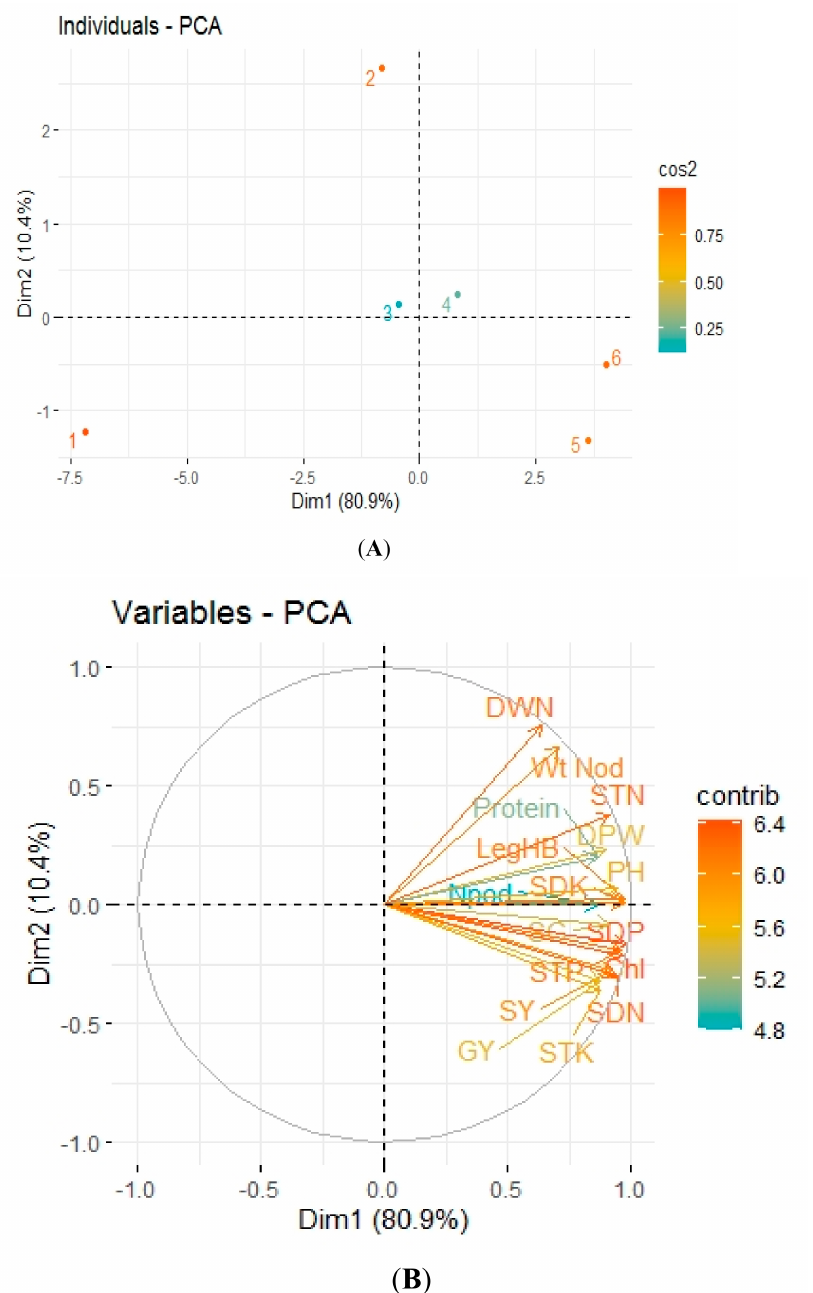
Figure 5. Score plots ( A ) and loading plots ( B ) of PCA on different attributes of chickpea by applica- tion of plant growth hormone alone and in combination with Rhizobium sp . Score plots ( A ) represents separation of treatments as (1) Control, (2) Rhizobium inoculation, (3) GA3 (10 − 4 M), (4) GA3 (10 − 5 M), (5) Rhizobium inoculation + GA3 (10 − 4 M), (6) Rhizobium inoculation + GA3 (10 − 5 M). The abbrevi- ations of loading plots ( B ) are as Grain Yield (GY), Stover Yield (SY), Chlorophyll contents (Chl), Number of pods (N pod), Seed carbohydrate contents (SC), Plant height (PH), Leghaemoglobin contents (Leg HB), Dry pod Weight (DPW), Protein contents (Protein), Weight of nodules (Wt Nod), dry weight of nodules (DWN), Stover K (STK), Seed N (SDN), Stover P (STP), Seed P (SDP), Stover N (STN), and Seed K